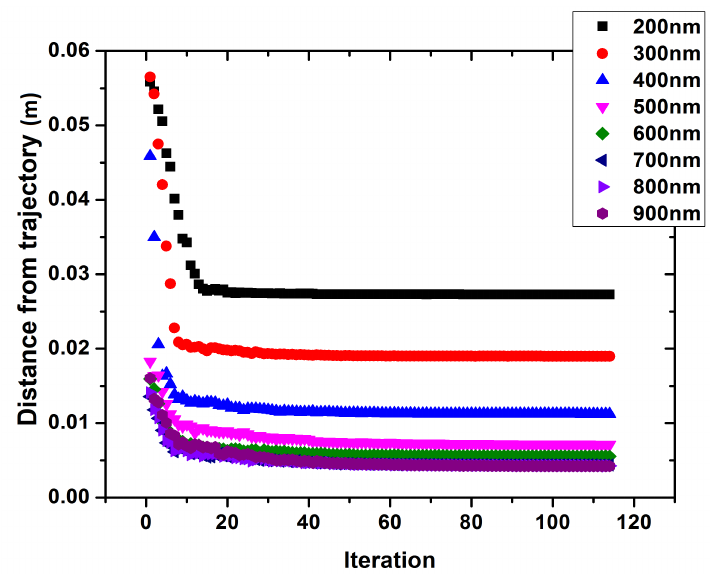
Figure 11. Distance of particles from the desired trajectory in each iteration of the computational method under inlet velocity of 0.06 m/s.